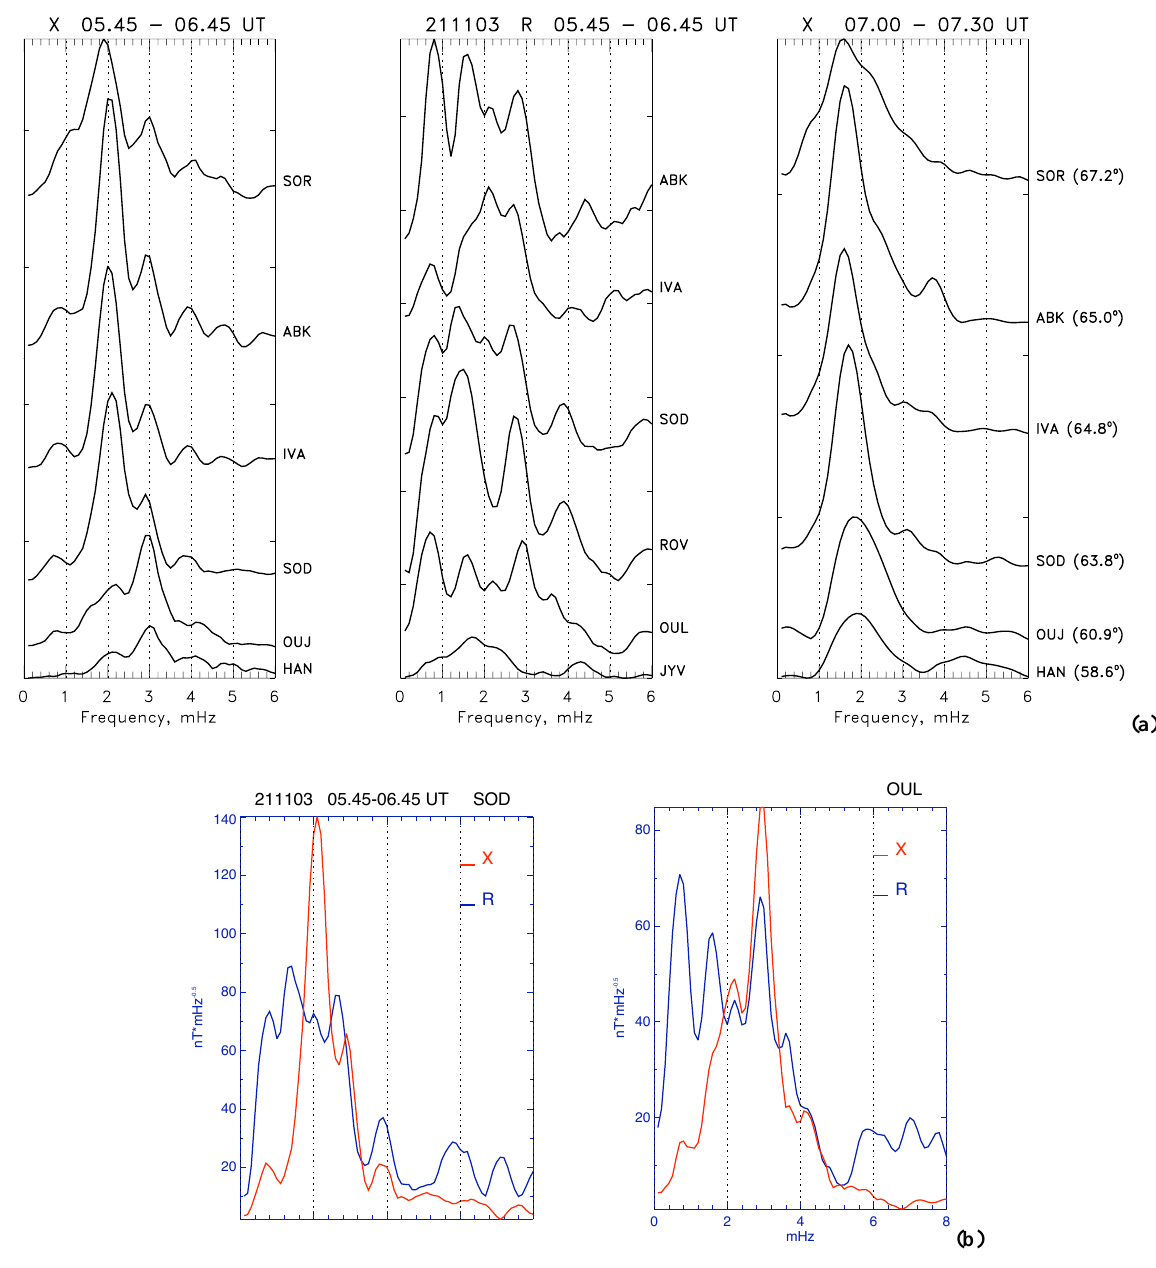
Fig. 4. (a) Fourier spectra of the X component of magnetic field variations and radio absorption (arbitrary units) at stations shown in Fig. 3 for the time intervals 05:45–06:45 UT and spectra of the X component in 07:00-07:30 UT; (b) comparison the spectra of Pc5 magnetic (red line) and absorption (blue line) pulsations at OUL and